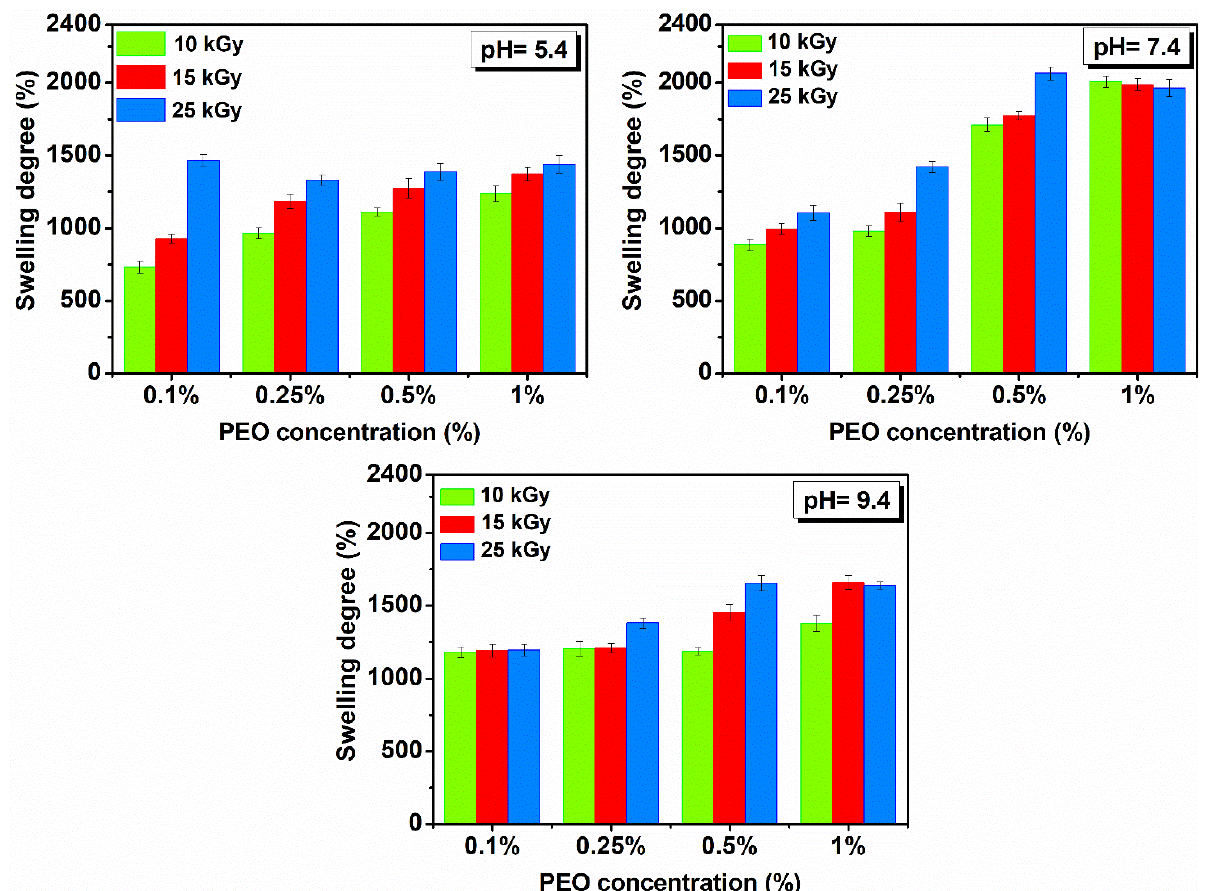
Figure 6. Swelling in solutions with pH = 5.4–9.4 and temperature of 37 °C determined 72 h for hydrogels prepared with (0.1–1)%